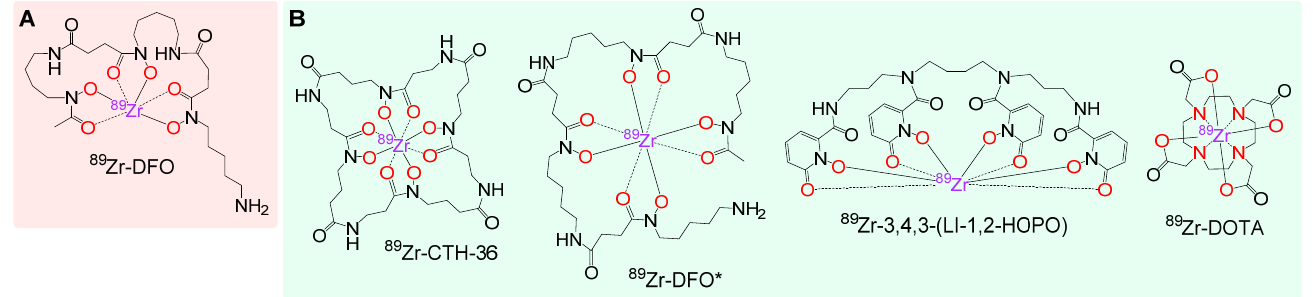
Figure 1. Structures of the complexes [ 89 Zr]Zr-DFO ( A ) and [ 89 Zr]Zr-DFO*, [ 89 Zr]Zr-CTH36, [ 89 Zr]Zr-3,4,3-(LI-1,2-HOPO) and [ 89 Zr]Zr-DOTA ( B ).